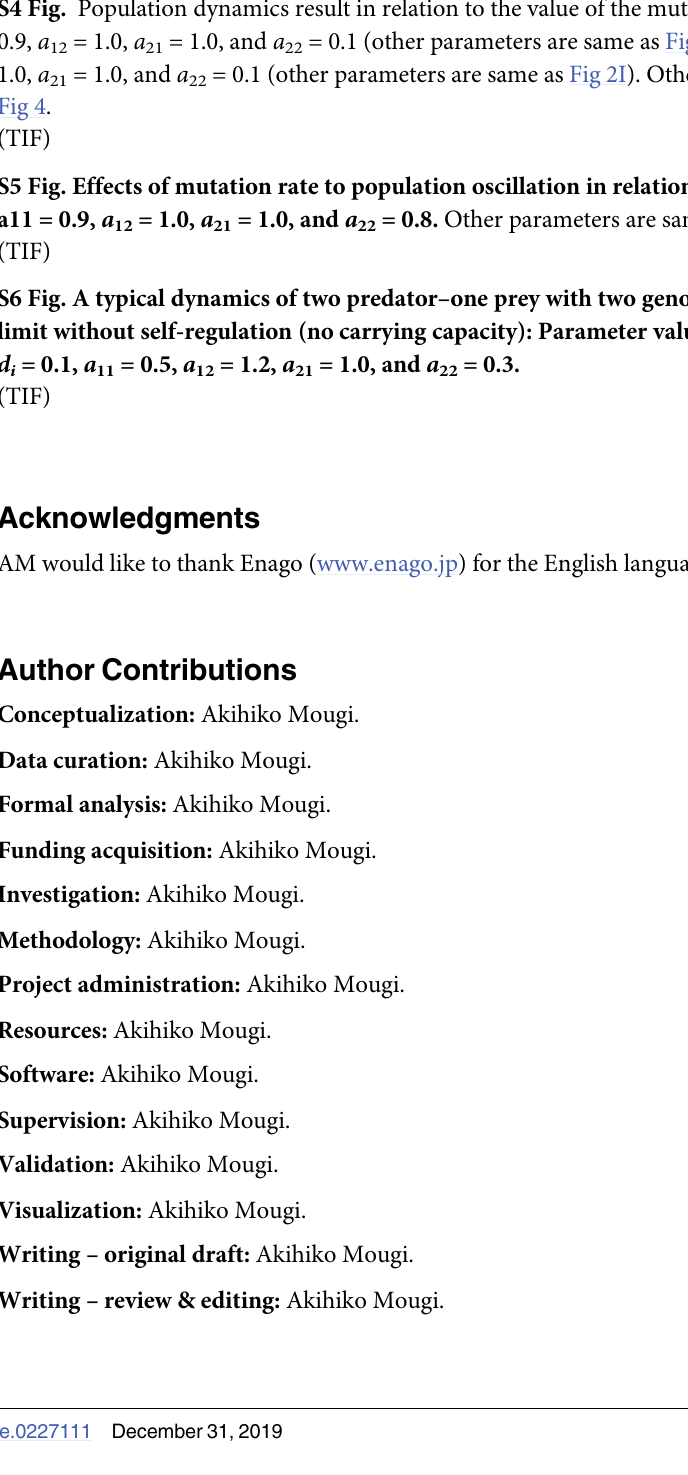
S3 Fig. Effects of genotype number to community persistence in multiple predator cases: In each different line, the systems have different number of predators. Parameters are same as those used in Fig 1A. S4 Fig. Population dynamics result in relation to the value of the mutation rate m : (a) a 0.9, a = 1.0, a = 1.0, and a = 0.1 (other parameters are same as Fig 2E). (b) a 12 21 22